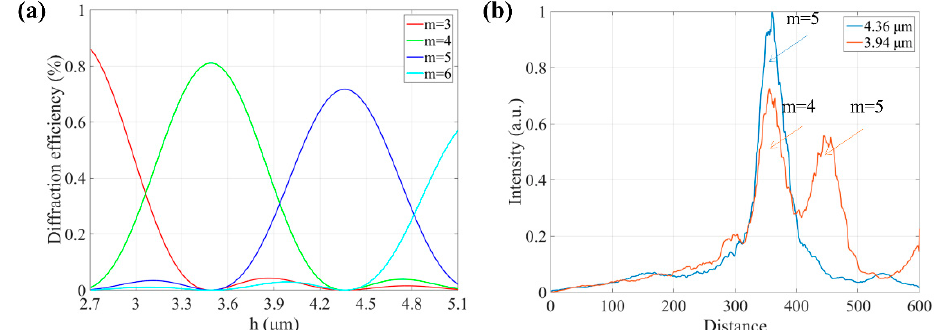
Figure 2. Simulation properties of MBG. ( a ) The dependence of theoretical diffraction efficiency on structural height h for MBG. In the figure, m represents the diffraction order, and the red, green, blue, and cyan line represent the diffraction efficiency on structural height h for MBG of the diffraction order 3, 4, 5, and 6, respectively; ( b ) The FDTD simulation of light field distribution for a MBG array with a height of 4.36 μ m and 3.94 μ m along propagation direction z.